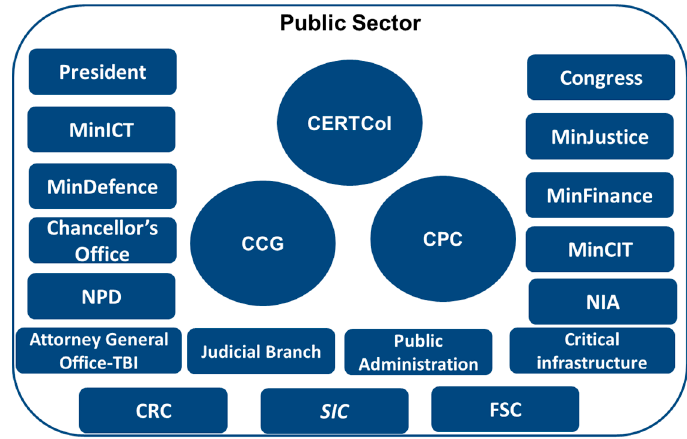
Figure 3. Public sector entities in the Cyber security Ecosystem of Colombia.